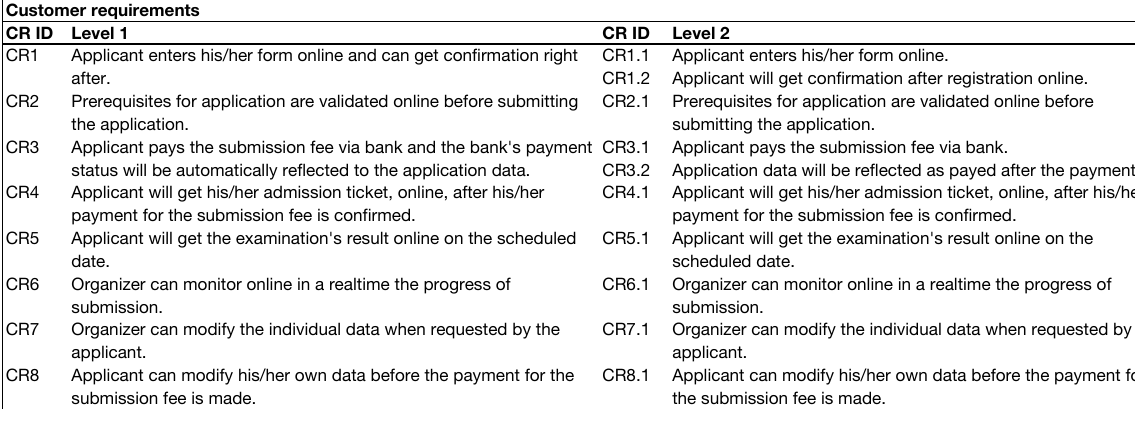
Table 2. Deployment of the customer requirements (excerpt)